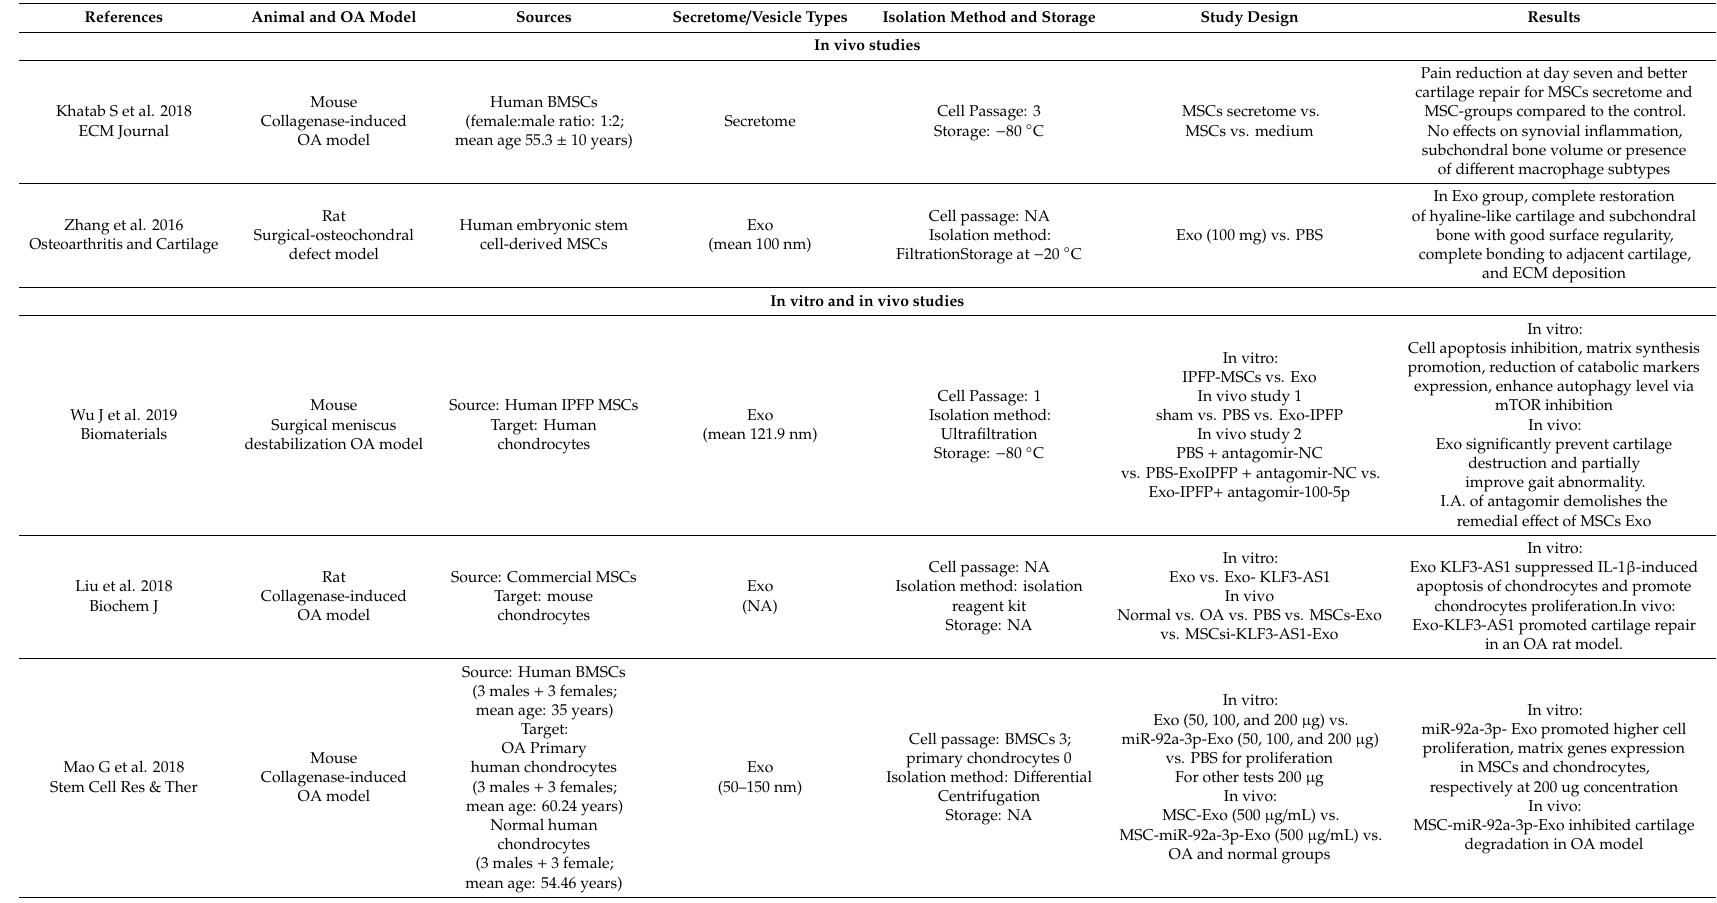
Table 2. Details of studies with in vitro and in vivo experiments. Abbreviations: IPFP, infrapatellar fat pad MSCs; I.A., intra-articular; Exo, Exosome; BMSCs, bone marrow-derived MSCs; MVs, microvesicles / microparticles; SMSC, synovial MSCs; ACs, articular chondrocytes; ES, embryonic stem cells; CM, conditioned medium; iMSC, induced pluripotent stem cell-derived MSCs; ECM, extracellular